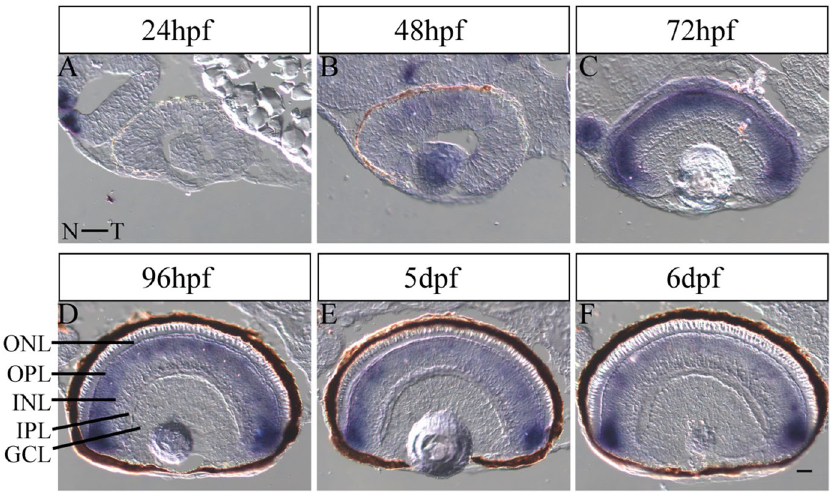
Figure 1. Expression pattern of lhx4 in zebrafish retinal development. All figures are horizontal sections along the temporal-nasal axis (T-N). ( A ) The expression of Lhx4 was not detected in the retina at 24 hpf. ( B ) The expression of Lhx4 in the dorsal-nasal of the retina was weak at 48 hpf. ( C ) Lhx4 was expressed in the ONL and INL at 72 hpf. ( D – F ) The expression of Lhx4 in the ONL and INL was gradually weakened, and the signal in the CMZ was relatively strong from 96 hpf to 6 dpf. ONL, outer nuclear layer; INL, inner nuclear layer; GCL, ganglion cell layer; OPL, outer plexiform layer; IPL, inner plexiform layer. Scale bar = 20